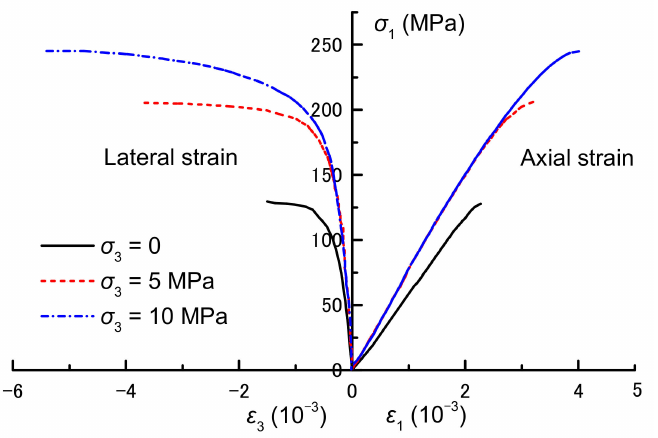
Figure 2. Prepeak stress–strain curves of typical granites under different confining pressures.